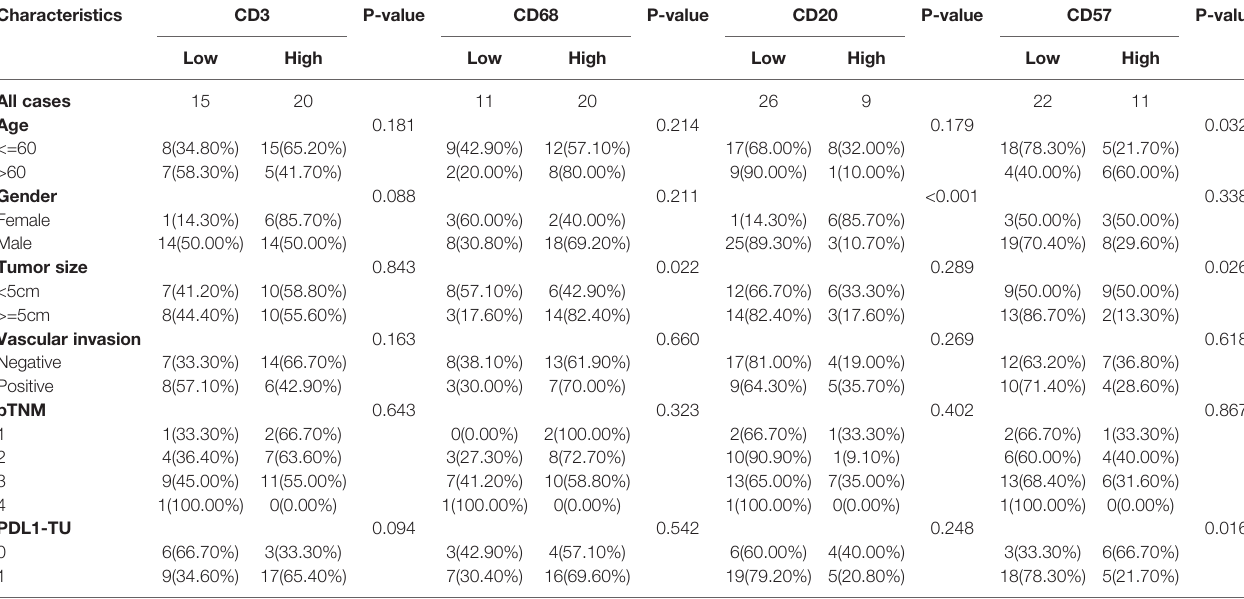
TABLE 2 | Correlation between density of tumor-in fi ltrating immune cells and clinicopathologic features of EBVaGC patients.